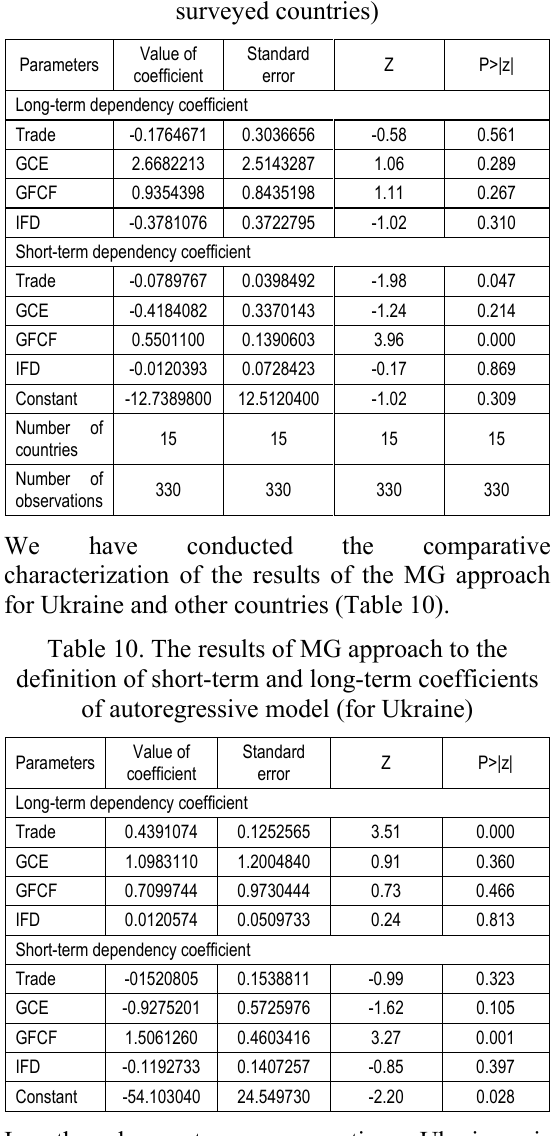
Table 9. Results of MG approach to determining